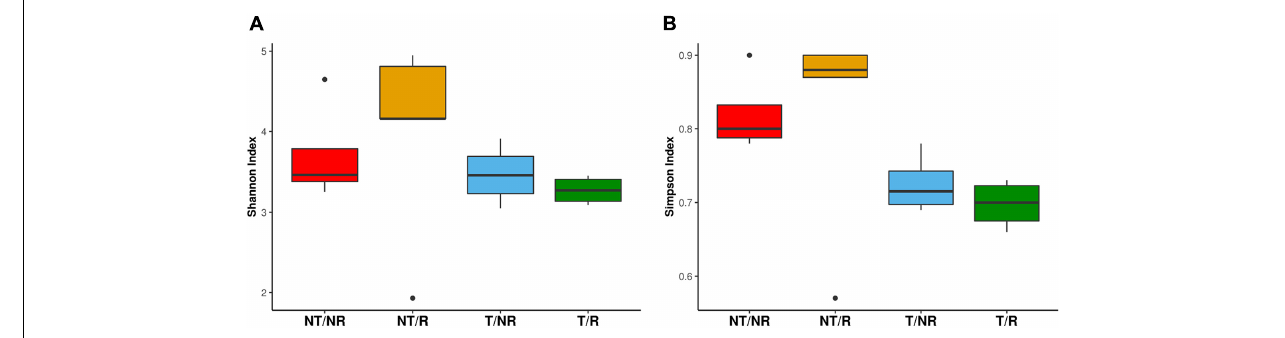
FIGURE 2 | Boxplot showing (A) the fungal Shannon diversity index and (B) Simpson diversity index, measured in the four analyzed conditions: Conventional Tilling (T) and No tilling (NT) under continuous cropping (NR) system and Rotation (R).